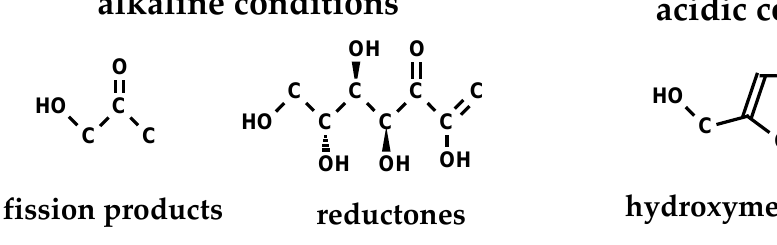
Figure 9. Maillard reactions that are the source of efficient antioxidants.